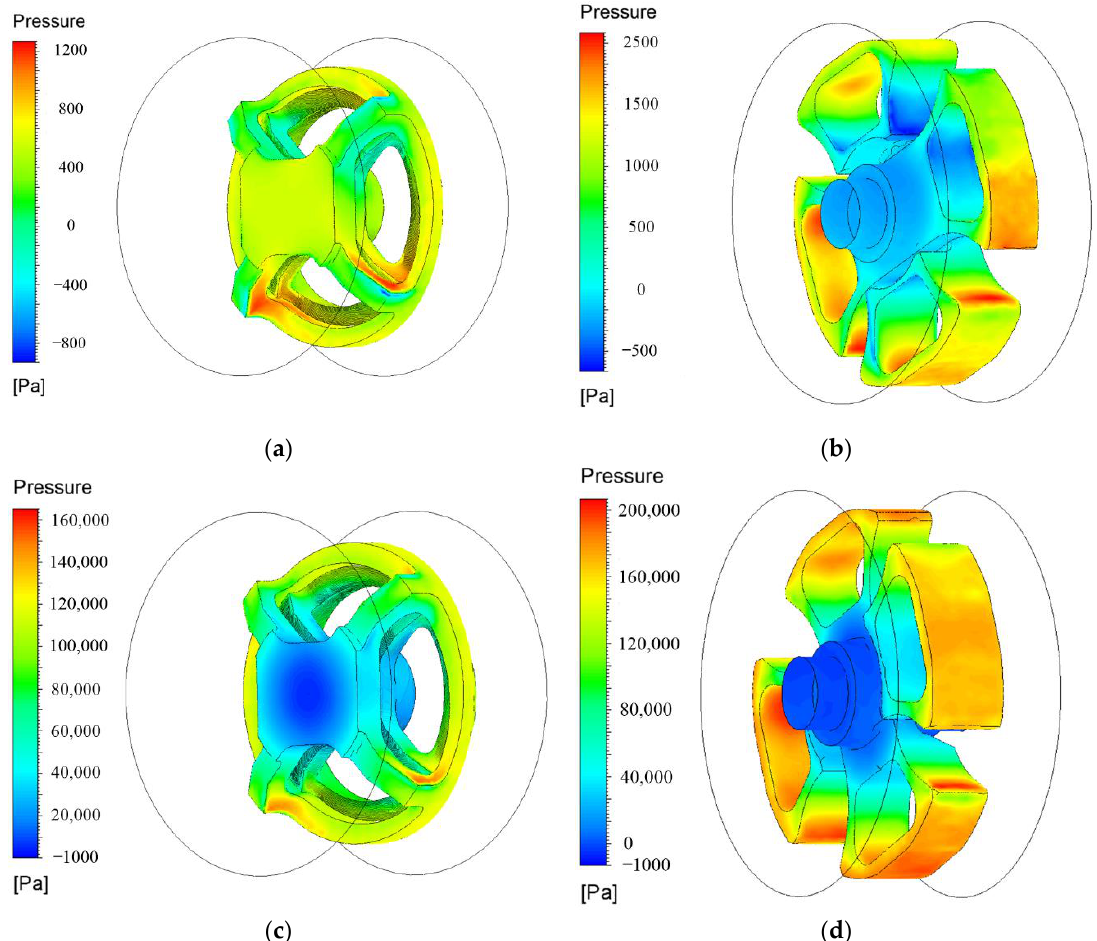
Figure 9. Pressure distributions of the two rotors: ( a ) The new rotor at 1000 rpm; ( b ) The former rotor at 1000 rpm; ( c ) The new rotor at 8000 rpm; ( d ) The former rotor at 8000 rpm.